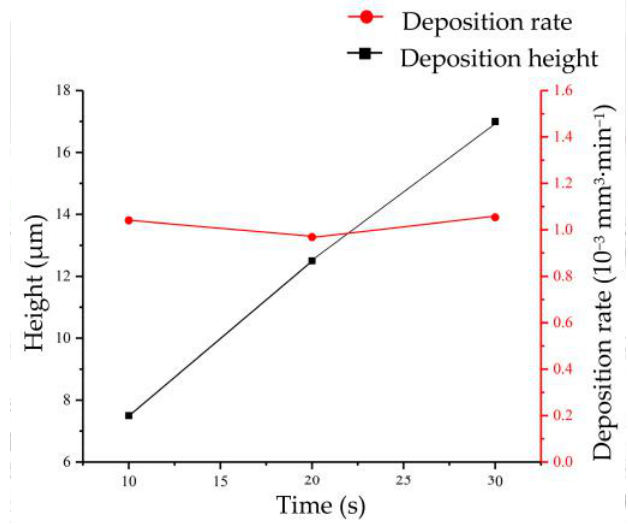
Figure 10. Deposition height and deposition rate at di ff erent discharge times.